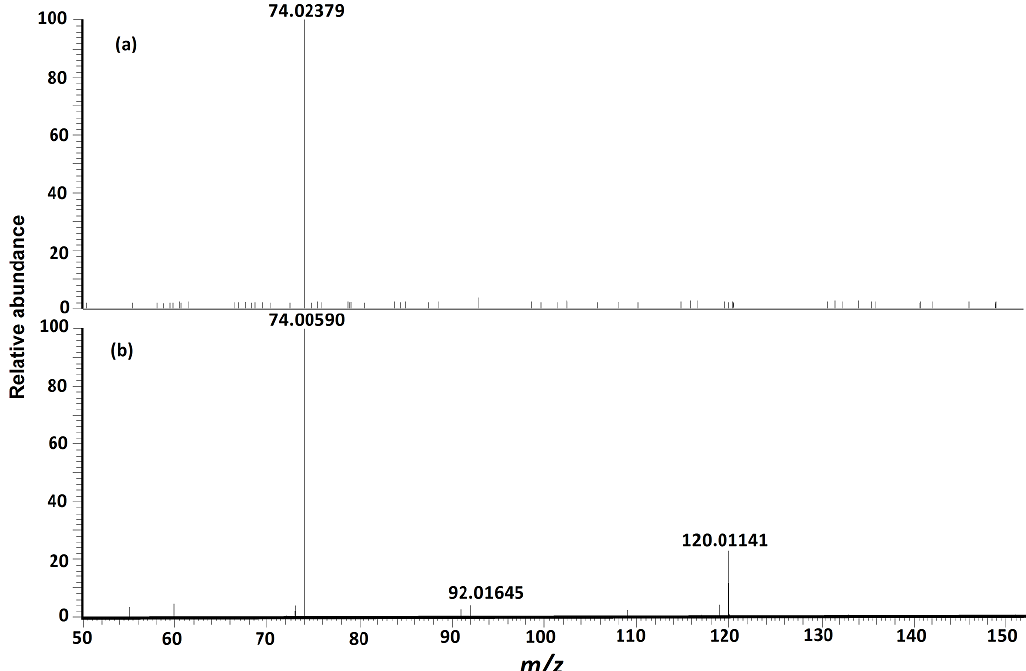
Figure 3. ( a ) Pseudo MS 3 spectrum of fragment ion at m/z 151.98341 from protonated cystine, which supports the proposed fragmentation pathway for formation of fragment at m/z 74.02359. ( b ) Pseudo MS 3 spectrum of the fragment ion at m/z 120.01137 from protonated cystine, which supports the proposed fragmentation pathway for formation of fragments at m/z 74.00582 and m/z 92.01640. With respect to the loss of C 3 H 5 NO 2 S, the m/z 122.02697 fragment should be protonated cysteine. This chemical identity was verified by examining its fragmentation products. Under low